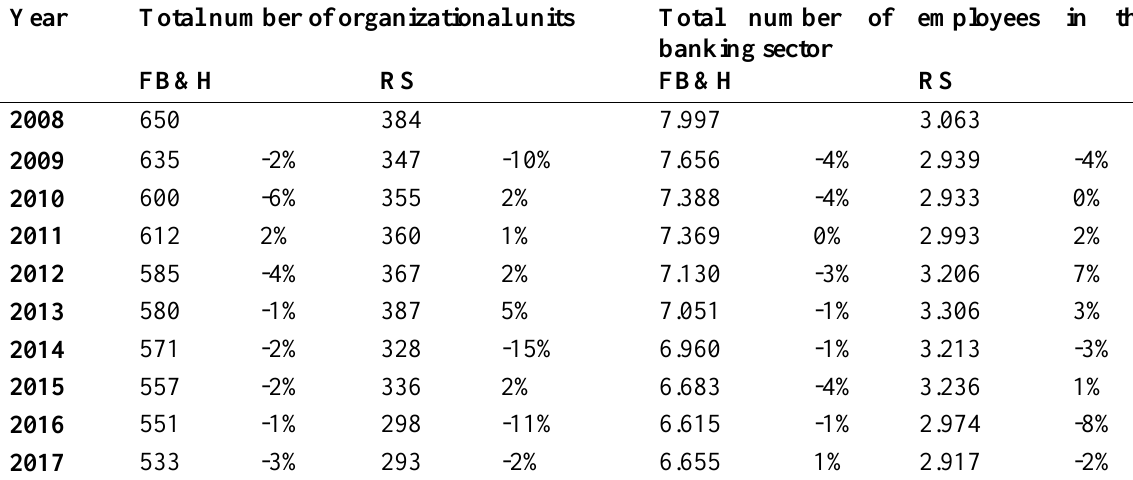
Table 2. Number of organizational units and number of employees in the banking sector in the period from